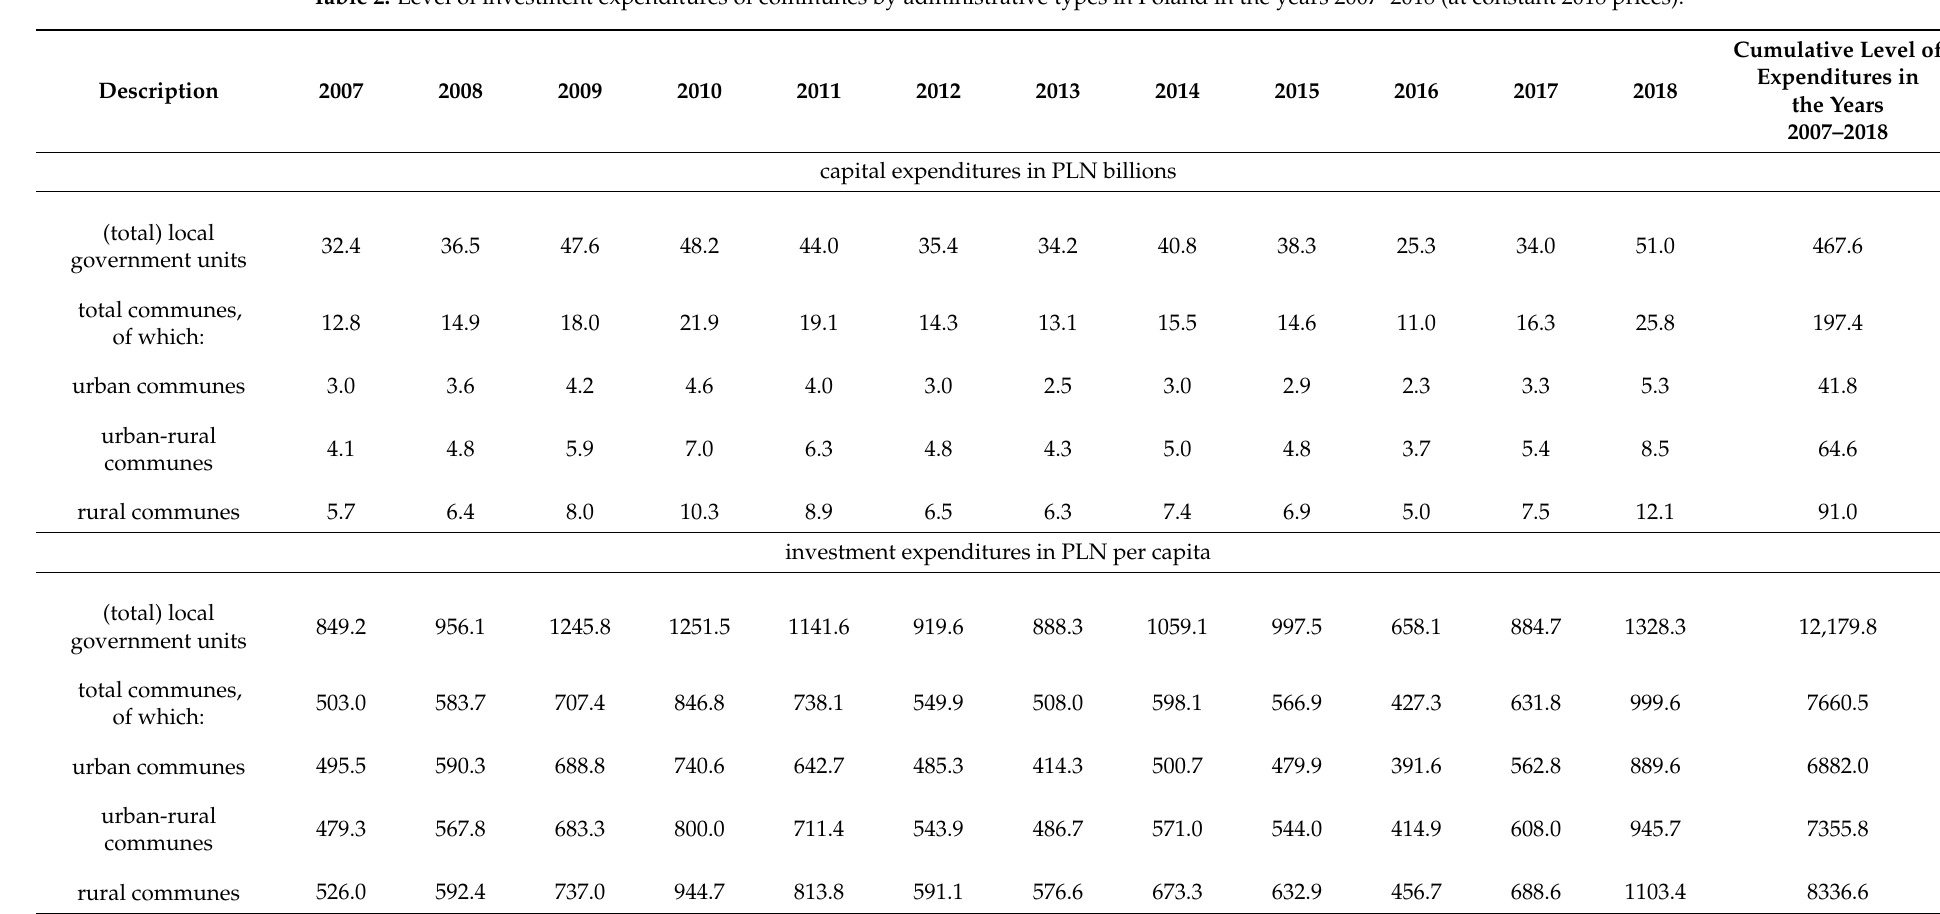
Table 2. Level of investment expenditures of communes by administrative types in Poland in the years 2007–2018 (at constant 2018